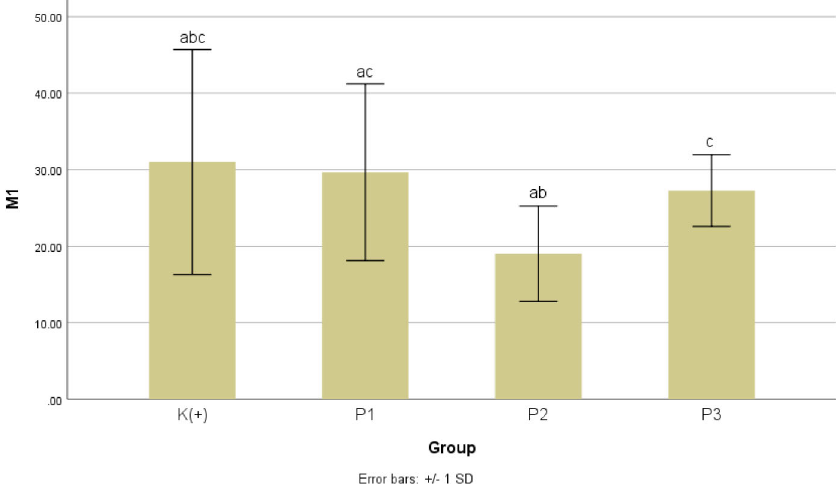
Figure 7. Graph of the mean value of the M1 count after giving black cumin